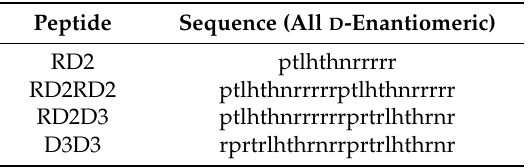
Table 1. Amino acid sequences of the applied D -enantiomeric